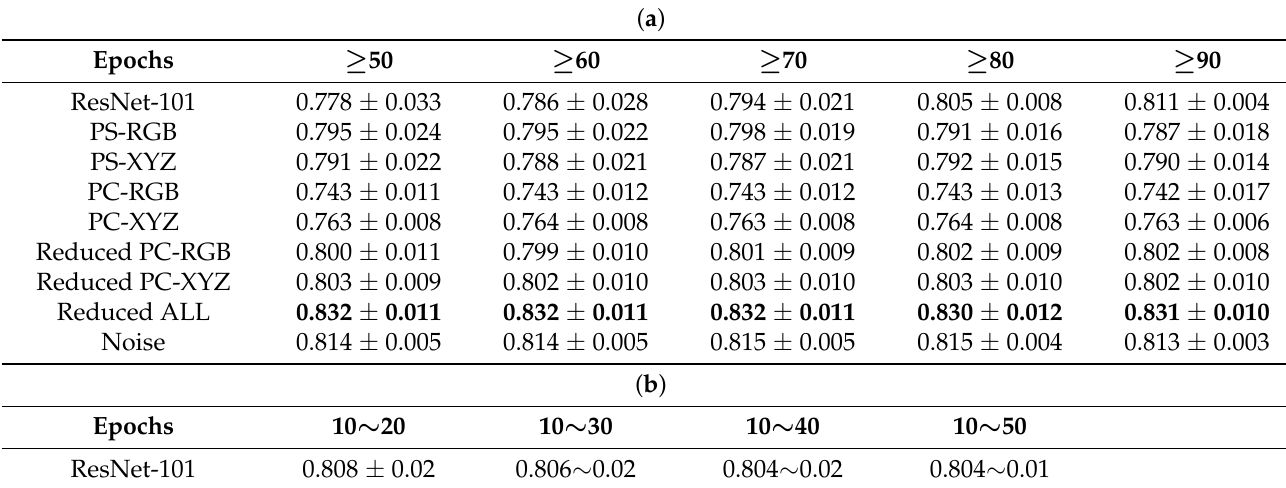
Table 3. ( a ) Average accuracies and standard deviations for Epoch n to Epoch 100 for ( n = 50,60,70,80, 90) on the testing dataset of all models. ( b ) Average accuracies and standard deviations from Epoch 10 to Epoch n for ( n = 20,30,40,50) for ResNet-101. Values with bold denote the best scores in corresponding